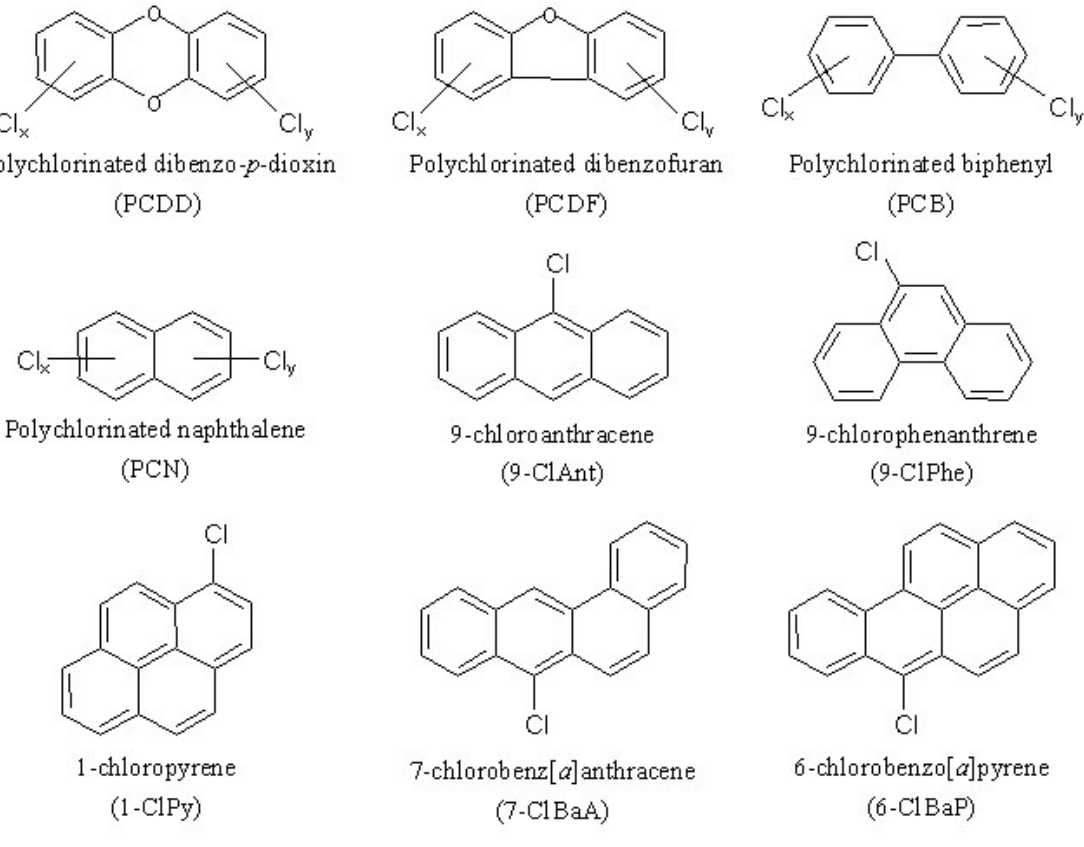
FIGURE 1. Structures of representative chlorinated aromatic